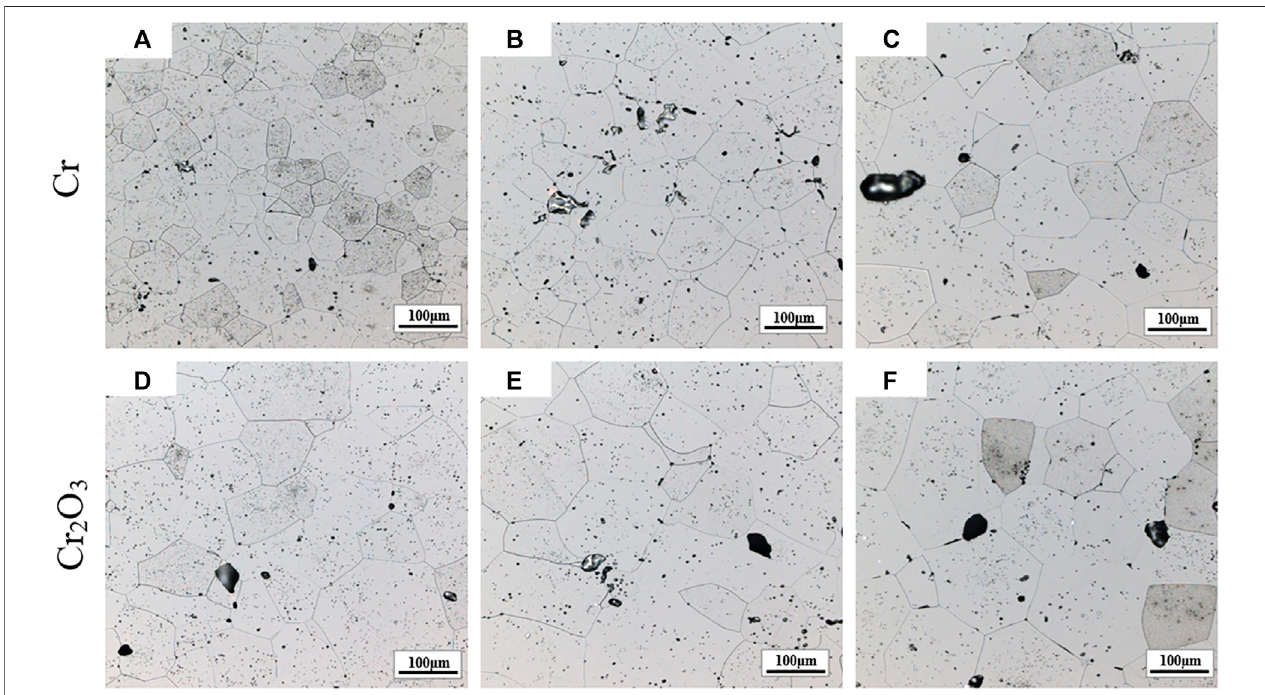
FIGURE 8 | The grain morphologies of UO 2 doped with different contents of Cr and Cr 2 O 3 . (A) 0.10 wt.% Cr; (B) 0.25 wt.% Cr; (C) 0.50 wt.% Cr; (D) 0.10 wt.% Cr 2 O 3 ; (B) 0.25 wt.% Cr 2 O 3 ; (C) 0.50 wt.% Cr 2 O